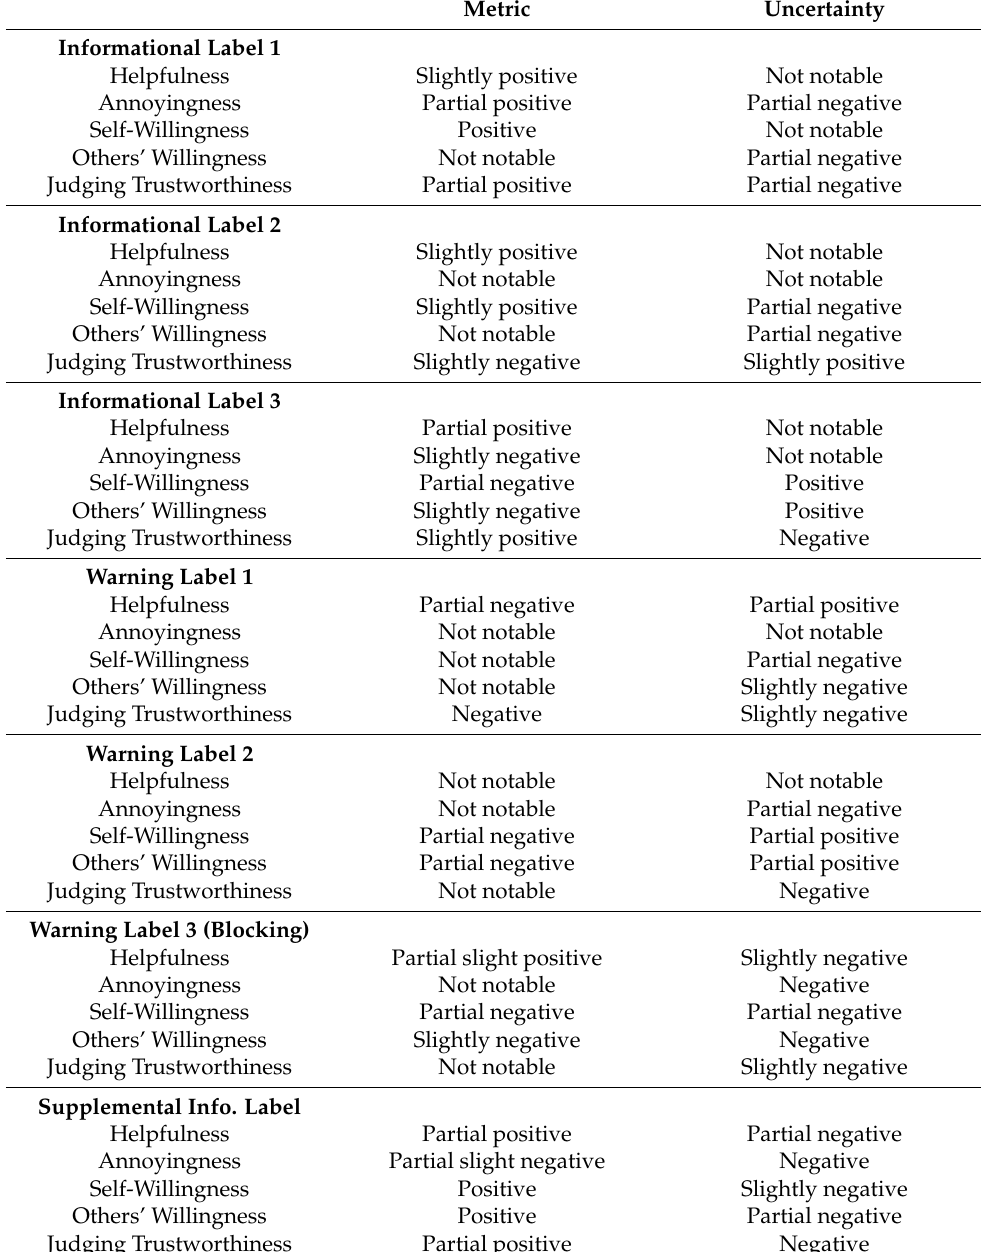
Table 3. Trends for label types for online usage level